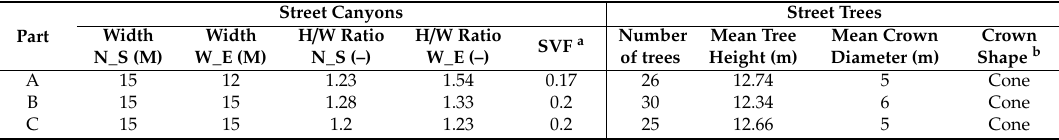
Table 2 . Intersection mean values for air temperature (T a ), relative humidity (RH) and wind speed (WS) on all measurement days (10:40–12:10 CEST).